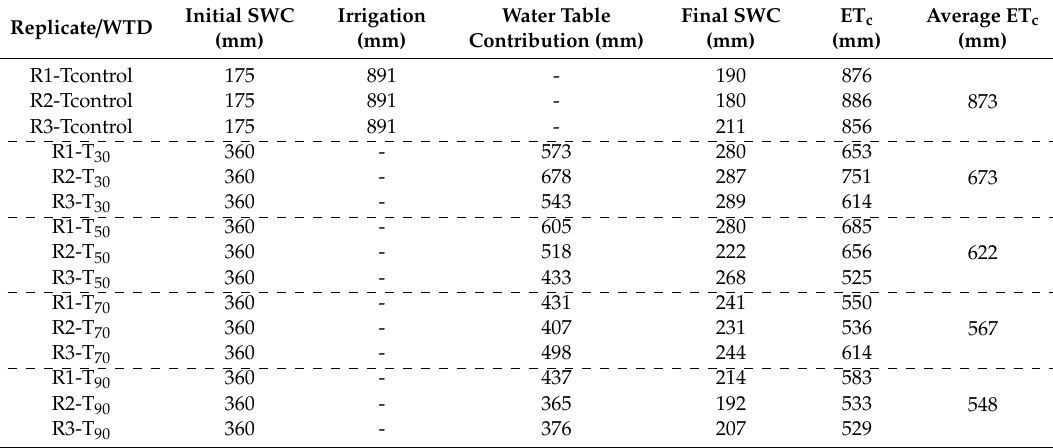
Table 2. Summary of total measured crop water use (ET c ) from di ff erent water table depths (WTD). Replicate /